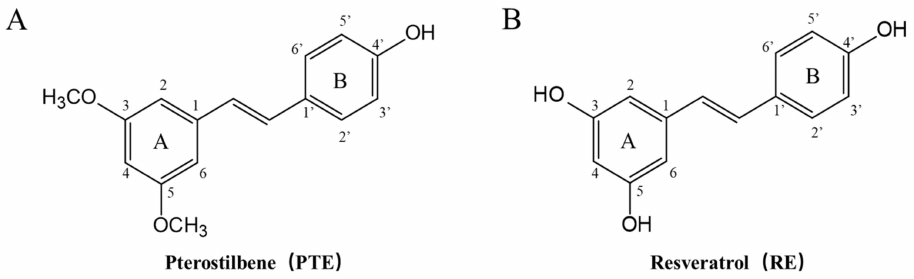
Figure 1. Structure of pterostilbene and resveratrol. ( A ) Pterostilbene (PTE). ( B ) Resveratrol